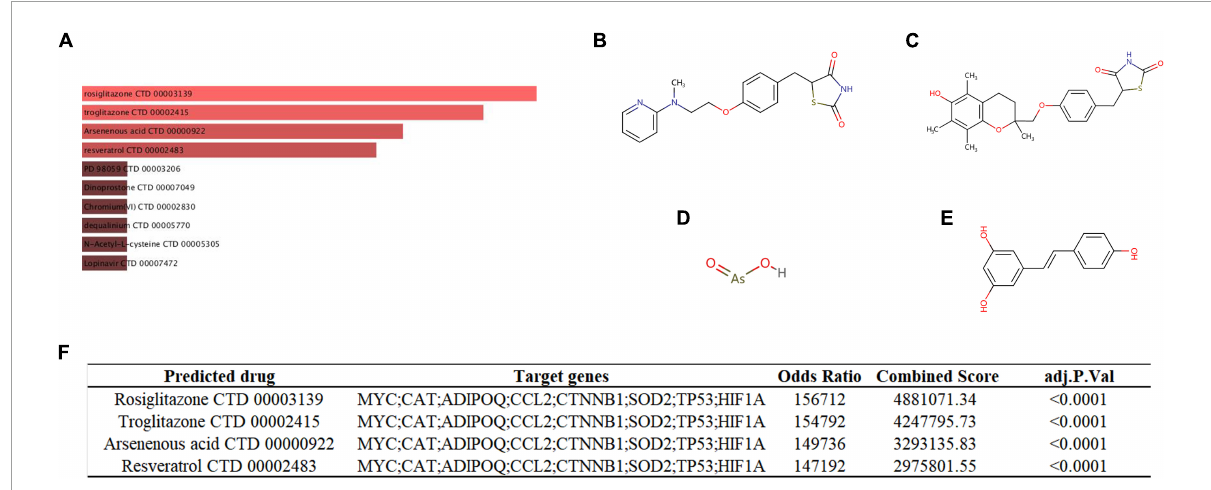
FIGURE9 (A) Targeted drugs prediction. The top 10 predicted targeted drugs ranked according to combined score in the DSigDB database. The chemical structures of rosiglitazone (B) , troglitazone (C) , arsenous acid (D) , and resveratrol (E) . (F) Detailed prediction information of drugs with strong drug-target